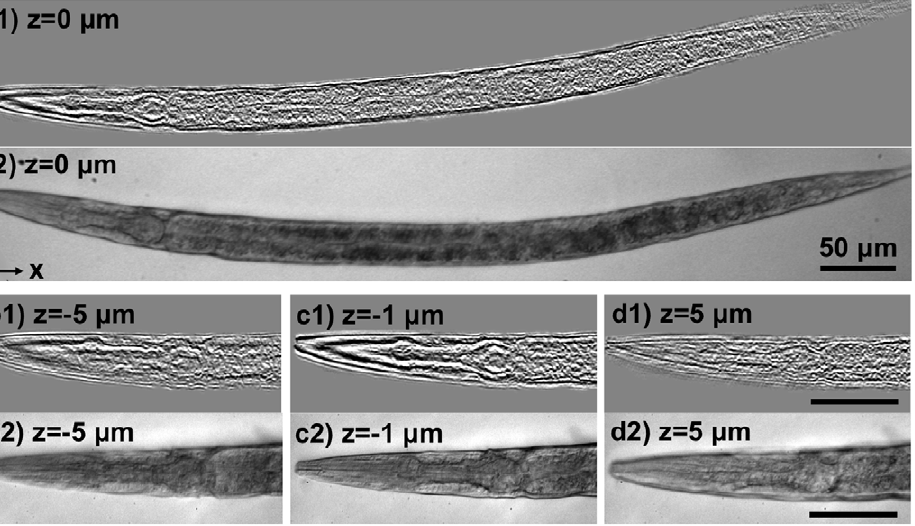
Figure 5. Gigapixel lensfree tomographic imaging of C.elegans on a chip. (a1) Shows the tomogram of a C. elegans nematode at z=0 m m plane. (a2) Shows a bright-field microscope image (20 6 , 0.4-NA) showing the entire worm for qualitative visual comparison. (b1, c1, d1) Show tomograms at different depth layers through the pharynx of the worm. (b2, c2, d2) Show bright-field microscope images (60 6 , 0.85-NA) for the same depth layers as in (b1, c1, d1) for visual comparison. All scale bars: 50 m m.